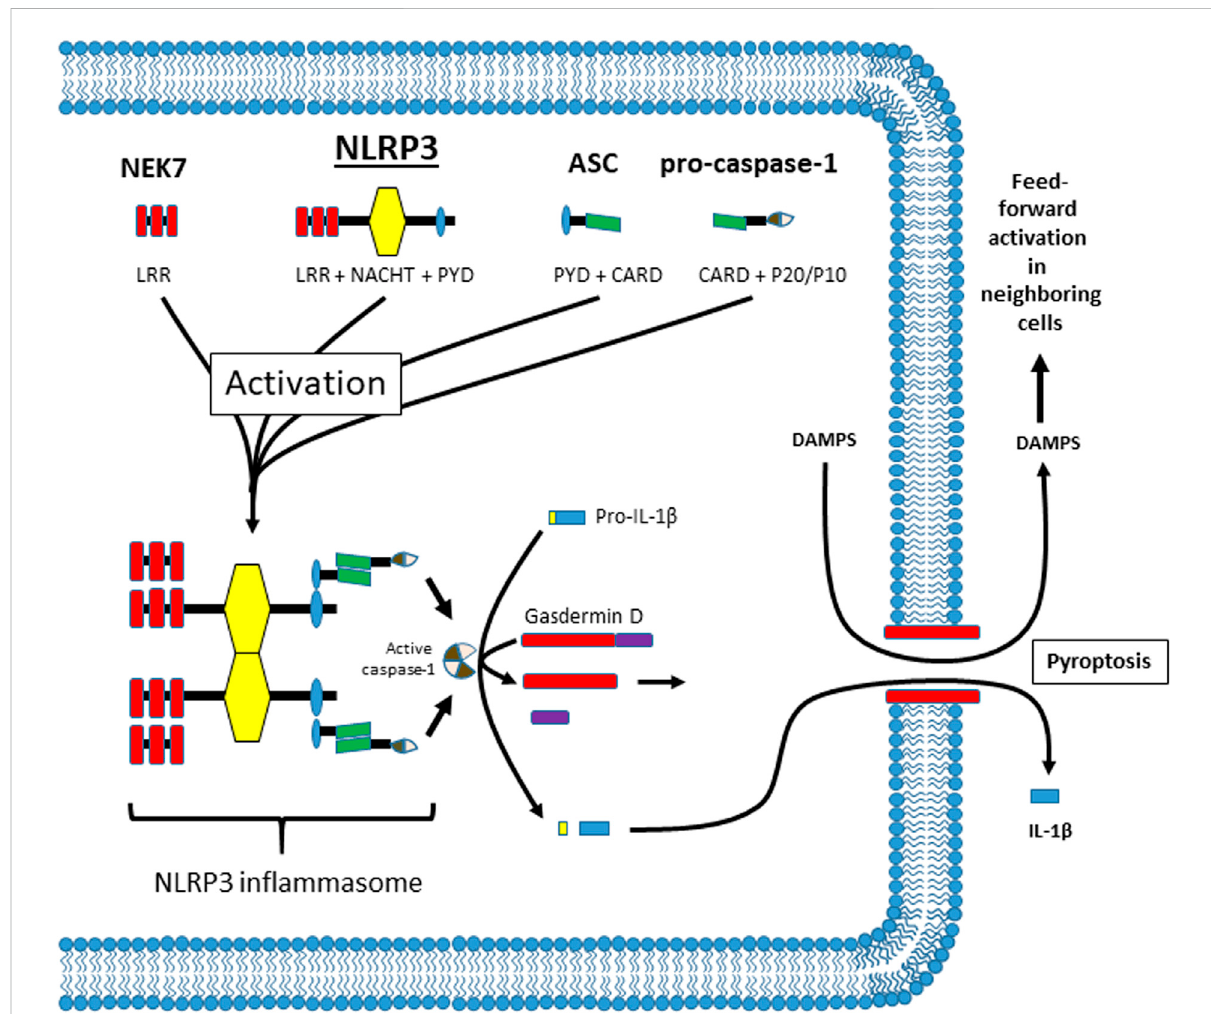
Illustration of the components of the NLRP3 in fl ammasome, its oligomerization after activation, and activities thereafter. The components of the NLRP3 in fl ammasome are illustrated at the top and are NEK7, NLRP3, ASC and pro-caspase-1. The individual domains in each protein are illustrated and named below the illustration (.i.e. LRR, NACHT, PYD, etc.). The exact mechanism of activation is highly debated but may take place through several different pathways. The result is that NEK7 facilitates NLRP3 oligomerization through the NACHT domains on NLRP3. In this fi gure only 2 individual NLRP3 molecules are shown for simplicity. ASC then binds NLRP3 through homotypic binding of its PYD domain. The CARD domain on ASC then binds the CARD domain on pro-caspase-1 and caspase-1 is cleaved through induced proximity. Cleavage releases a P20 and a P10 subunit which combines with the same subunits from the cleavage of another molecule of pro-caspase-1 to form an active tetramer. Active caspase-1 then cleaves pro-IL-1 β and gasdermin D. It also cleaves pro-IL-18 if it is present but this cleavage is not shown for simplicity. The n-terminus of gasdermin D then moves to the plasma membrane where it assembles into a pore. This pore then facilitates a programmed necrosis termed pyroptosis. By lysing the cells, pyroptosis releases the mature IL-1 β while also releasing intracellular DAMPs (and all the intracellular components) which then can activate NLRP3 in nearby cells in a feed forward